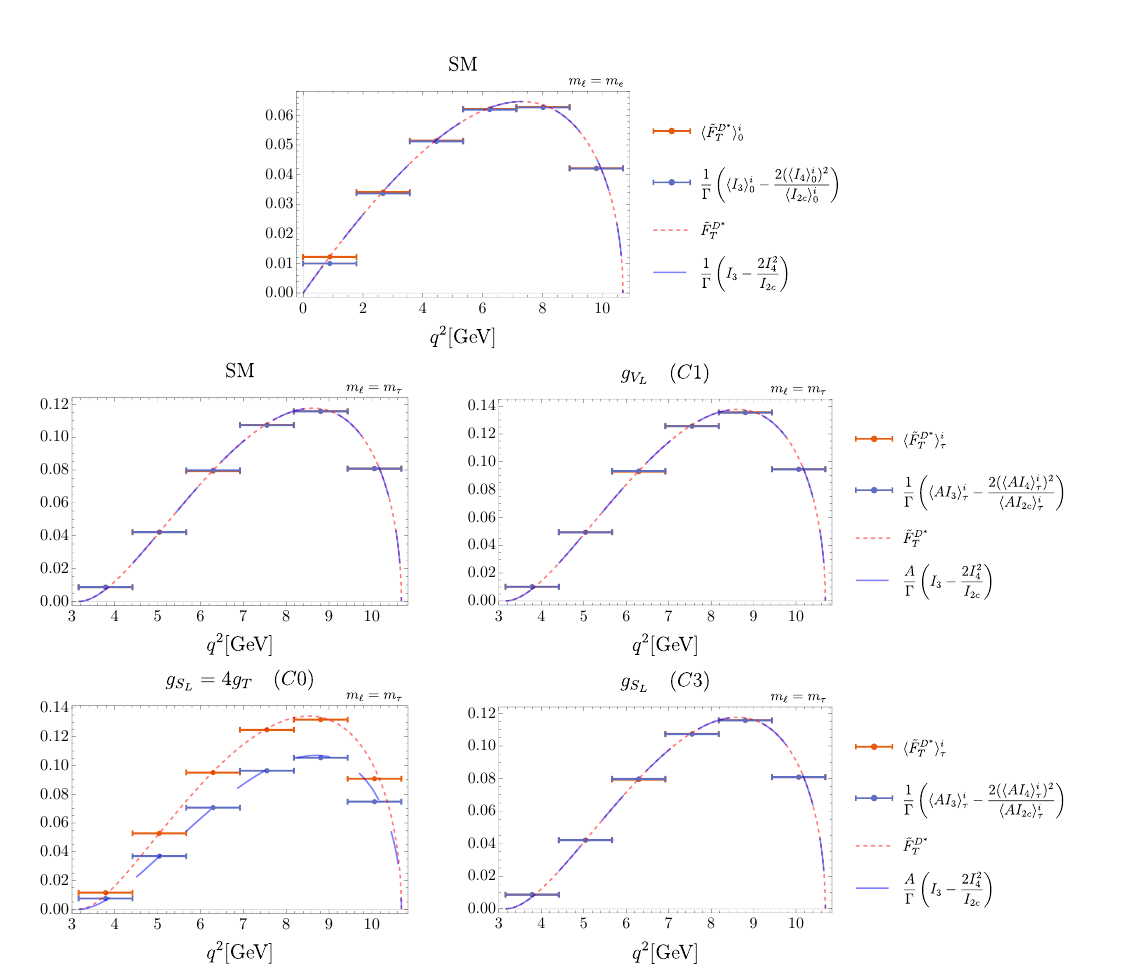
Figure 2. Same as (cid:12)gure 1 for eq. (4.19).